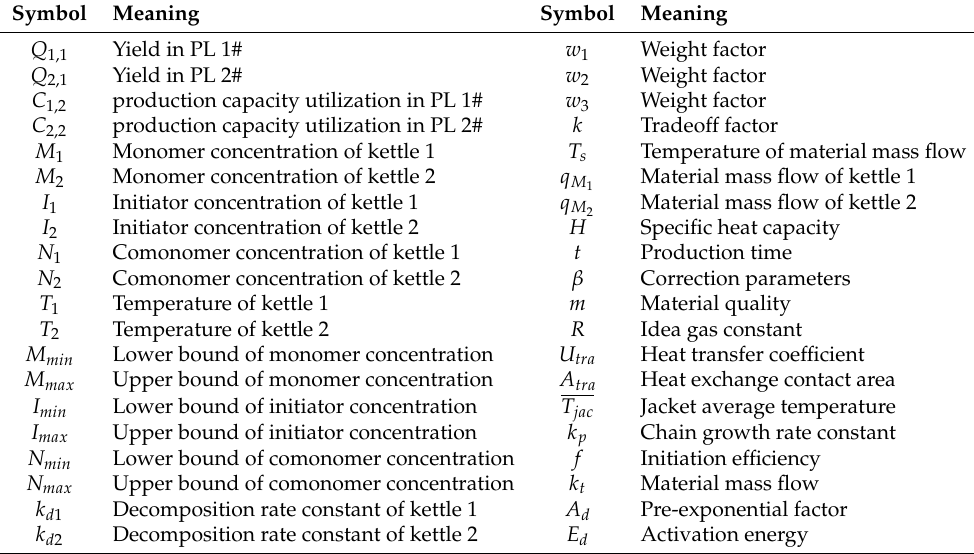
Table 1. Symbols and meanings.